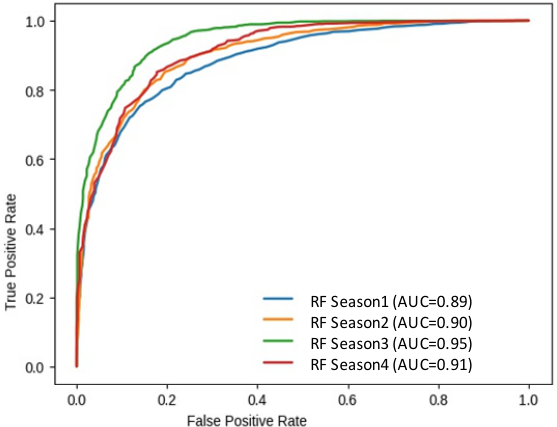
Table 5. Seasonal accuracy assessment of RF.